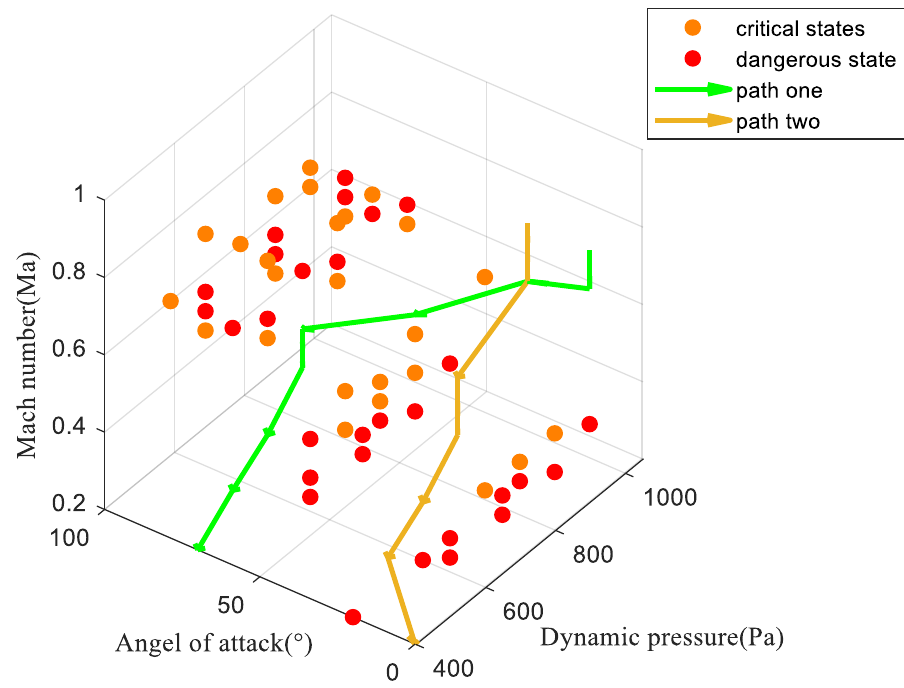
Figure 24. Control schemes implemented during the process of falling of the fairing.